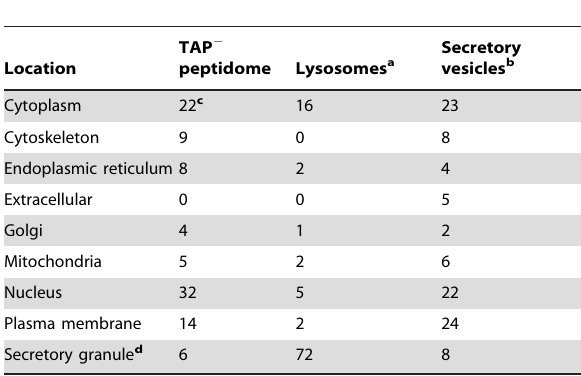
Table 4. Distribution of proteins by cell location.